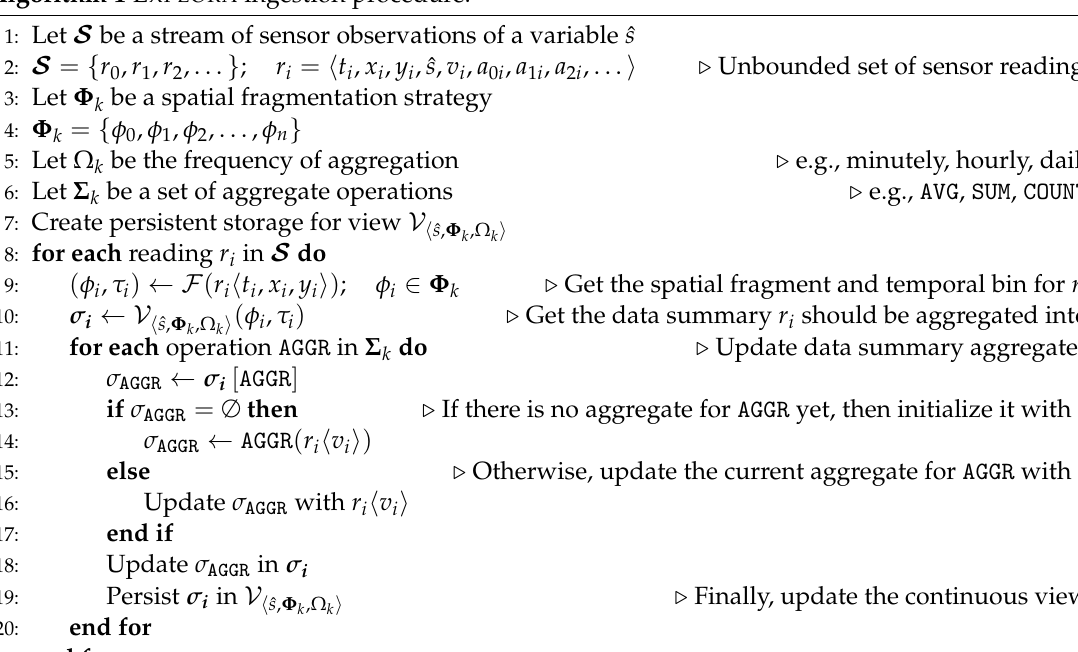
Algorithm 1 E XPLORA ingestion